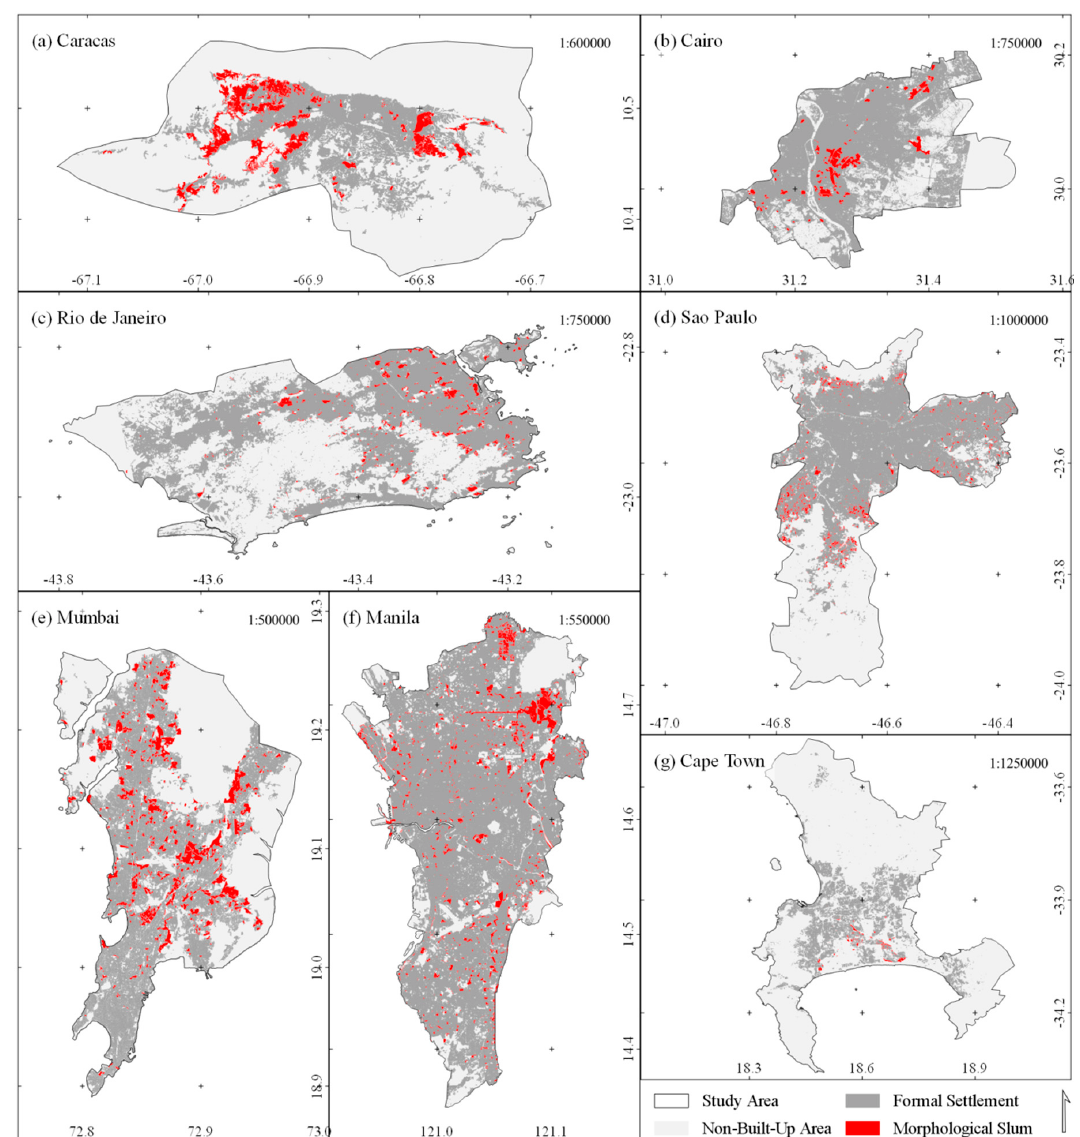
Figure 6. Classification of morphological settlements types (formal and morphological slums) within the particular administrative boundaries of the seven sample cities: ( a ) Caracas, ( b ) Cairo, ( c ) Rio de Janeiro, ( d ) Sao Paulo, ( e ) Mumbai, ( f ) Manila, ( g ) Cape Town.